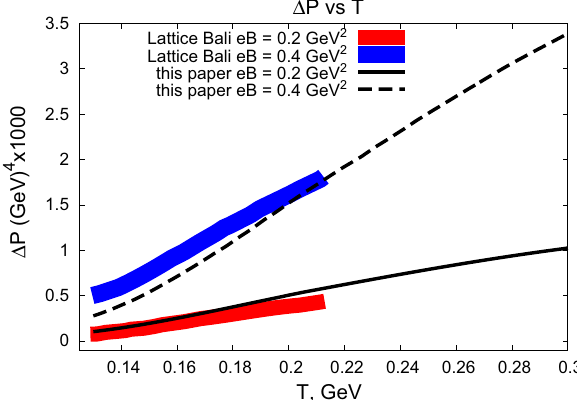
Fig. 2 The dependence of (cid:12) P ( T , B ) on T for fixed values of eB = 0 . 2 , 0 . 4 GeV in comparison with lattice data from [27]. For lattice results, the line thickness corresponds to the estimated error of the cal- culation